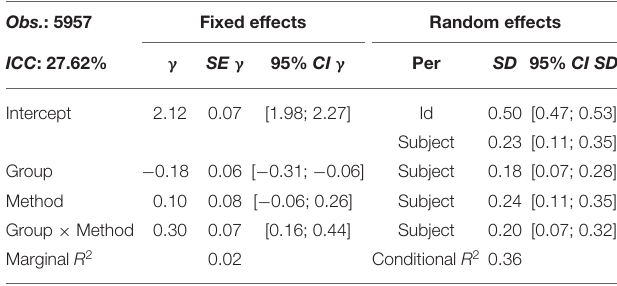
eleven school subjects. Obs. :